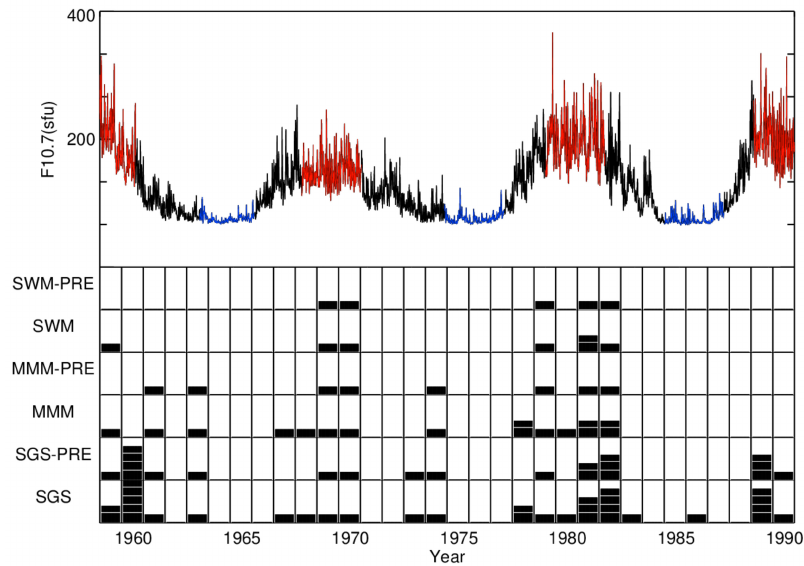
Figure 7. Daily F10.7 from 1959 to 1990 (upper panel; red and blue denotes solar activity high years and low years respectively) and the number of events each year (lower panel; one black rectangle represents one event). SGS means all super geomagnetic storms (Dst < − 200 nT) during the period 1959–1990. Similarly, SGS-PRE means an SGS with a previous geomagnetic storm within no more than seven days. MMM and SWM show the number of ionospheric weak response events to SGS; MMM-PRE and SWM-PRE are the number of ionospheric weak response events to